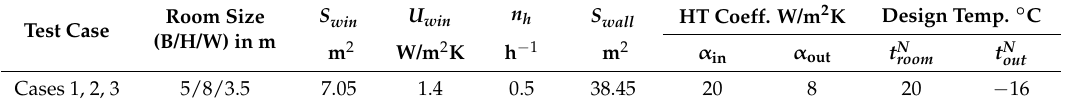
Table 1. Geometry and characteristic parameters for test cases 1, 2, and 3.